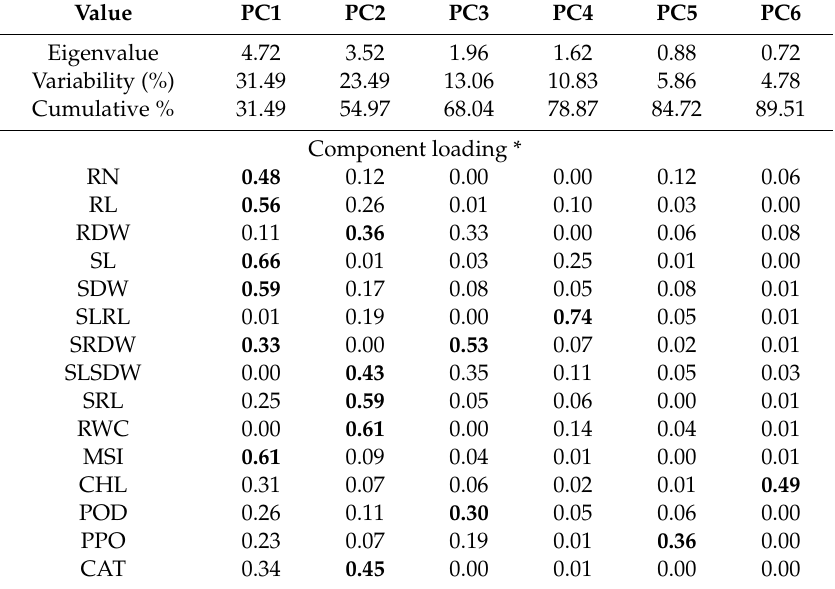
Table 4. Principal component analysis of 16 wheat genotypes, eigenvalues, proportion, and cumulative variance for the first six components for measured traits at three salinity levels ( n =